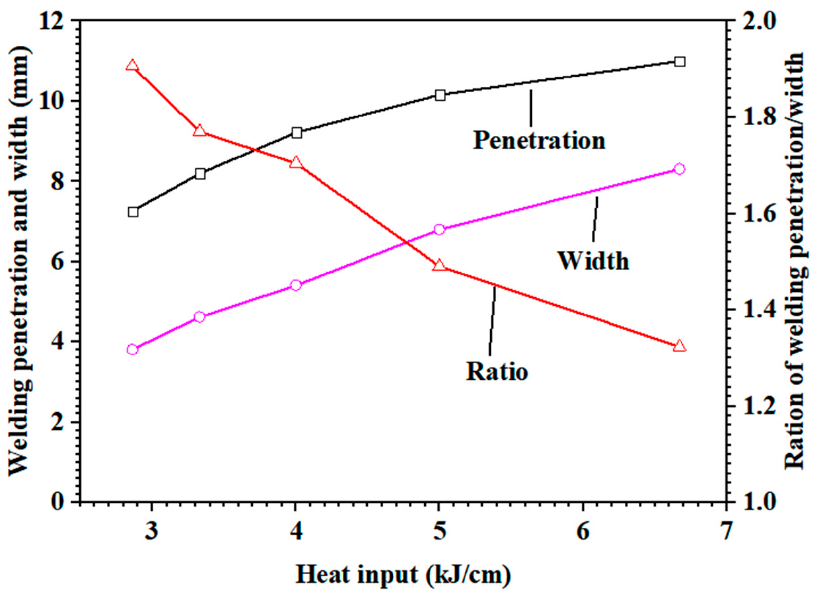
Figure 3. The size of weld penetration, width and the ratio of weld penetration/width.